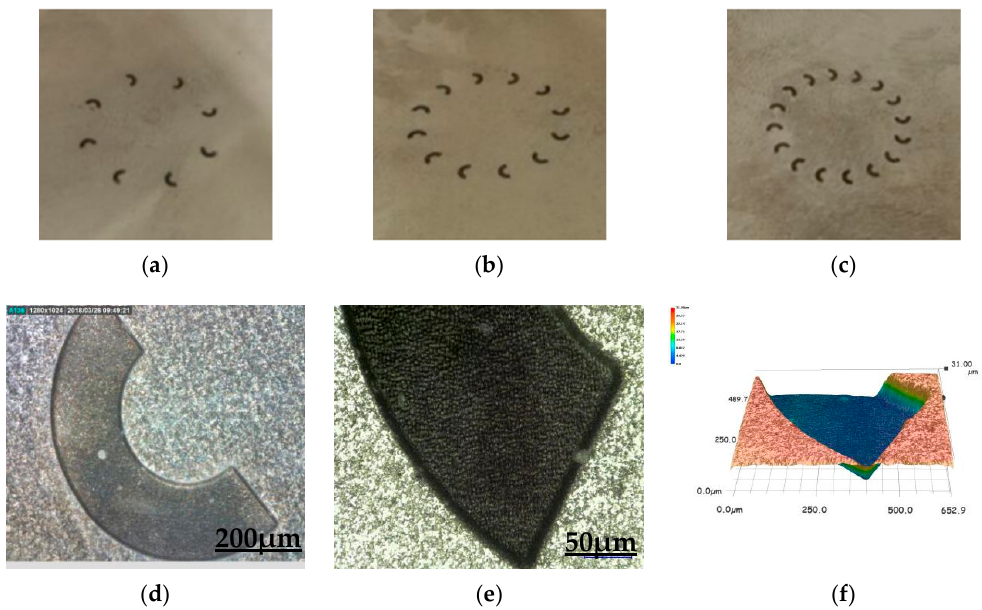
Figure 3. Semicircular ring micro-texture arrays obtained by laser processing and micro-morphology of semicircular ring taken by DINO-LITE microscope and ultra-high accuracy microscope. ( a ) Semicircular ring texture with an area occupancy ratio of 7%; ( b ) Semicircular ring texture with an area occupancy ratio of 10%; ( c ) Semicircular ring texture with an area occupancy ratio of 13%; ( d ) Semicircular ring texture microscopic morphology with a scale of 200 µ m; ( e ) Semicircular ring texture microscopic morphology with a scale of 50 µ m; ( f ) Semicircular ring texture 3D morphology.